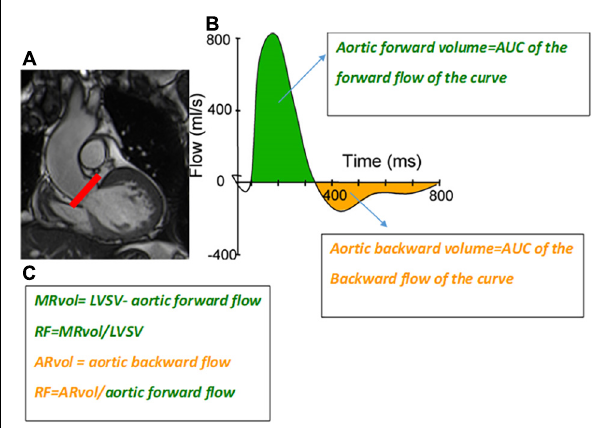
FIGURE 3 | (A) (left) Slice position for the phase-contrast velocity mapping sequence. (B) Flow curve (mL/s) through the aorta at the level of the line on panel (A) . Aortic forward volume is calculated as the area under the curve (AUC) of the forward flow on the flow curve (green area); aortic backward volume is calculated as the AUC of the backward flow on the flow curve (orange area). (C) Formula to obtain mitral and aortic regurgitant volume (MRvol and ARvol) and regurgitant fraction (RF) are shown at the left bottom.